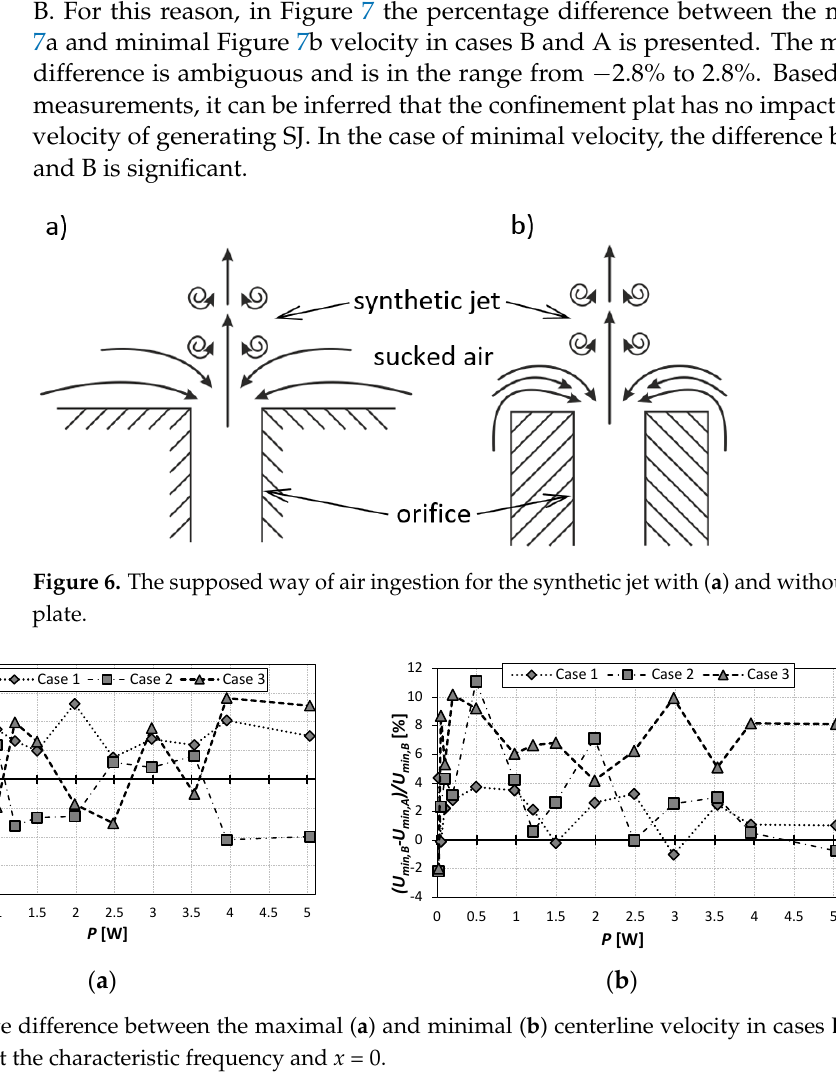
function of real power, at the characteristic frequency and x = 0.